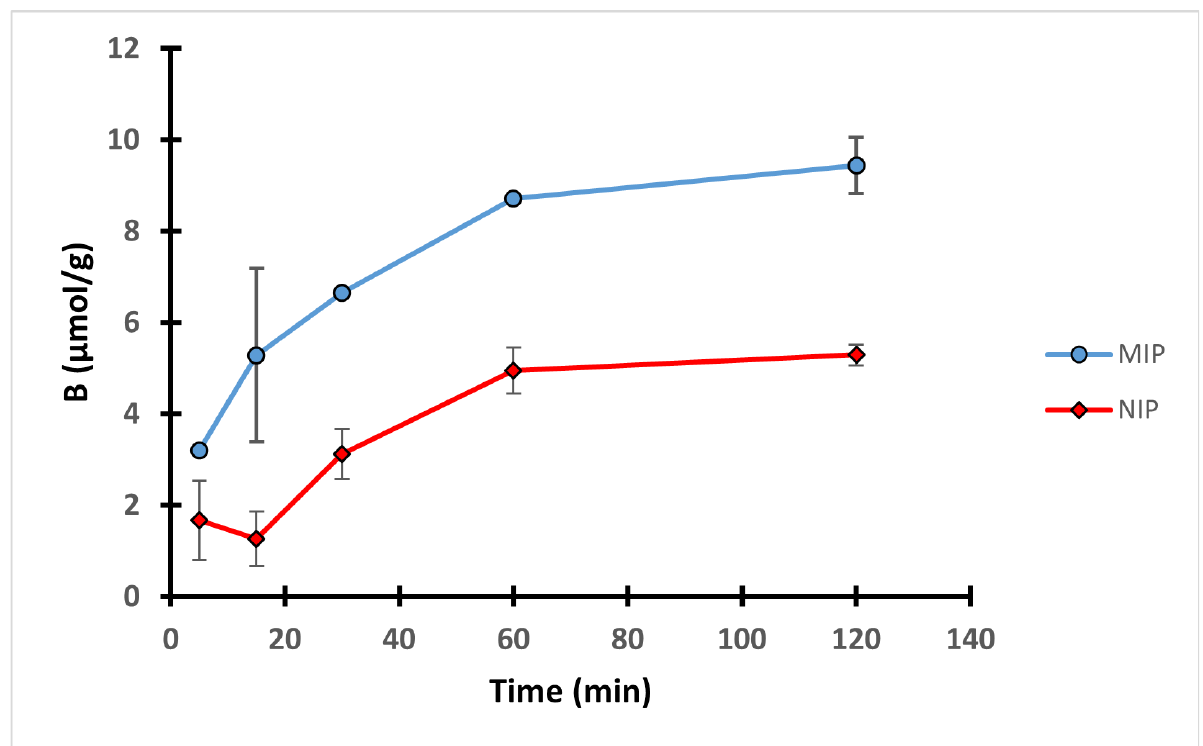
Figure 5. Uptake profiles of MIP C and NIP C over 2 h equilibrium rebinding study in methanol.